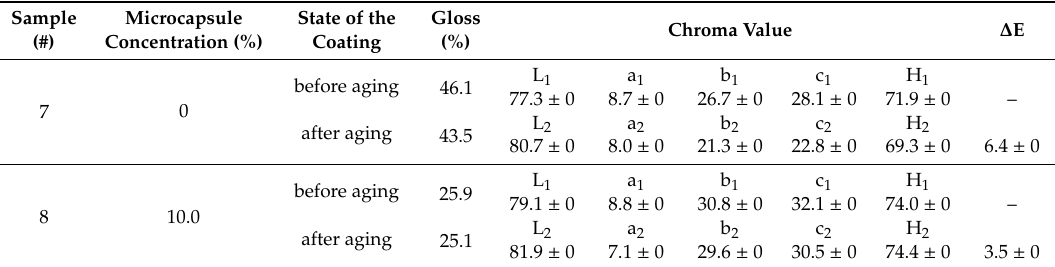
E ff ect of Aging and Stability Test on the Chroma Di ff erence and Gloss Value of Waterborne Coating.